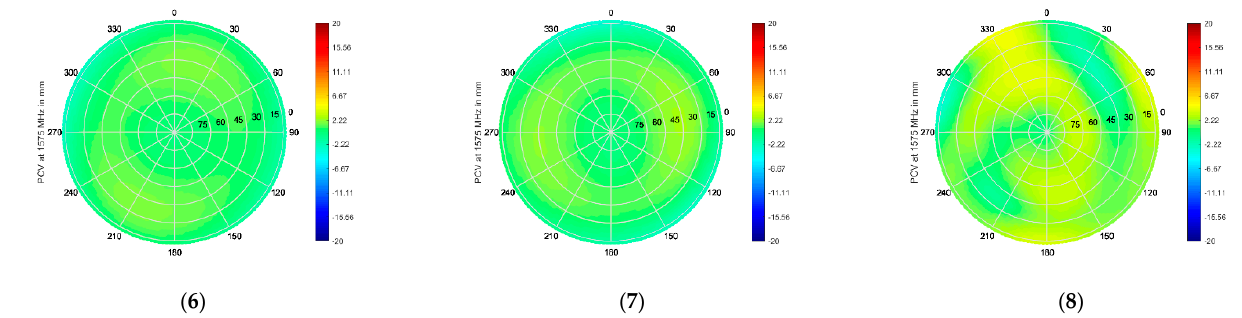
Figure A3. Normalized phase center variations (PCVs) in mm at L1/E1 central frequency of the antennas measured at DLR; from left to right, from top to bottom: ( 1 ) Leica AR25 R4; ( 2 ) Novatel GNSS-750; ( 3 ) Javad RingAnt-DM; ( 4 ) Space Engineering GalExpAnt; ( 5 ) DLR internal design; ( 6 ) Novatel 703-GGG; ( 7 ) Navxperience Nav3G+C; ( 8 ) Tallysmann VSE6028 VeroStar.